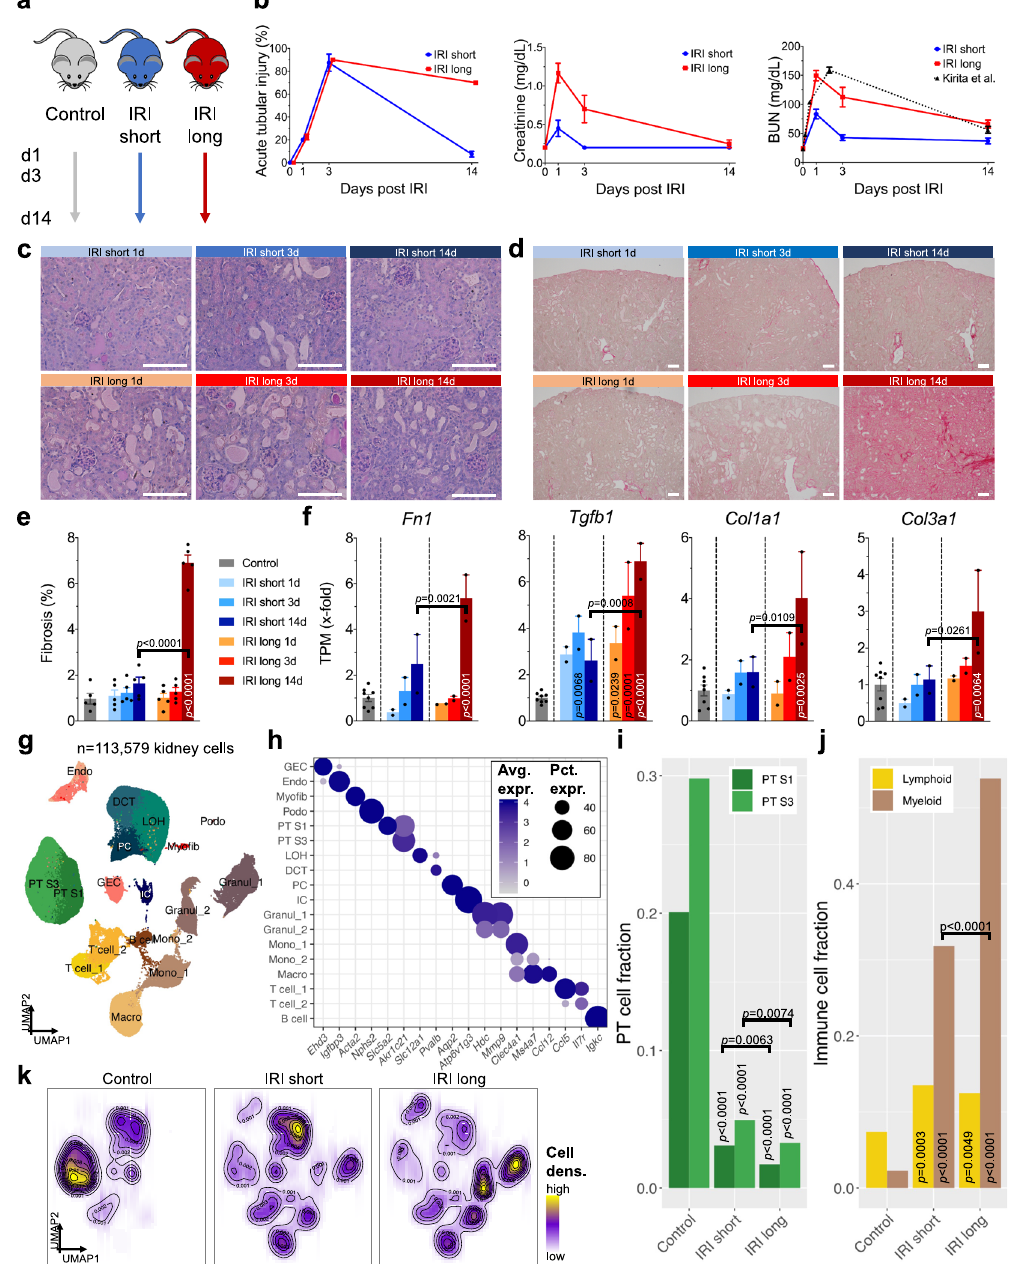
Fig. 1 Single-cell transcriptome dynamics of adaptive and maladaptive regeneration following bilateral renal ischemia. a Experimental setup. Male C57BL/6 mice were subjected to short and long ischemia and followed for 1, 3 and 14 d ( n = 12). Bulk and scRNA-seq was performed in n = 2 mice per condition and time point and compared to n = 6 controls; artwork own production and from https://smart.servier.com, license https://creativecommons.org/licenses/by- sa/3.0/). b Histopathological evidence of acute tubular injury (left panel), blood creatinine (middle panel) and BUN changes (right panel) 1, 3, and 14 d post-IRI. BUN of long IRI was comparable to previously published data (Kirita et al.); means±SEM. Representative light microscopy of Periodic acid-Schiff ( c ) and Sirius red ( d )-stained kidneys; scale bars = 50 µ m. e Fibrosis quanti fi cation from ( d ); means±SEM; p values are given for one-way ANOVA comparisons between Control and IRI groups and between short and long IRI groups, respectively. f Bulk RNA-seq analysis of fi brosis markers Fn1, Tgfb1, Col1a1 , and Col3a1 ; means±SEM; p values are given for one-way ANOVA comparisons between Control and IRI groups and between short and long IRI groups, respectively. g UMAP projection of 113,579 cells ( n = 6 controls, n = 6 short, n = 6 long IRI samples) passing rigid quality control fi ltering (nFeatures> 200 and < 3000, mt %<50, doublet removal) and after dataset integration with LIGER, yielding 18 cell clusters: GEC glomerular endothelial cell; Endo endothelial cell; Myo fi b myo fi broblast; Podo podocyte; PT S1 proximal convoluted tubule; PT S3, proximal straight tubule; LOH, loop of Henle; DCT, distal convoluted tubule; PC, principal cell; IC, intercalated cell; Granul, granulocyte; Mono, monocyte; Macro, macrophage; T cell; B cell. h Cell type-speci fi c expression of marker genes for manually annotated clusters. Dot size denotes percentage of cells expressing the marker. Color scale represents average gene expression values. i , j Fractions of PT ( h ) and immune cell ( i ) clusters strati fi ed by treatment group (Control; IRI short; IRI long). Statistical signi fi cance for comparisons was derived using differential proportion analysis, with a mean error of 0.1 over 100,000 iterations; p values are given for comparisons between Control and IRI groups and between short and long IRI groups, respectively. k Changes in cell type proportions between treatment groups (Control; IRI short; IRI long), visualized as cell density. NATURE COMMUNICATIONS| (2022) 13:4018 |https://doi.org/10.1038/s41467-022-31772-9|www.nature.com/naturecommunications